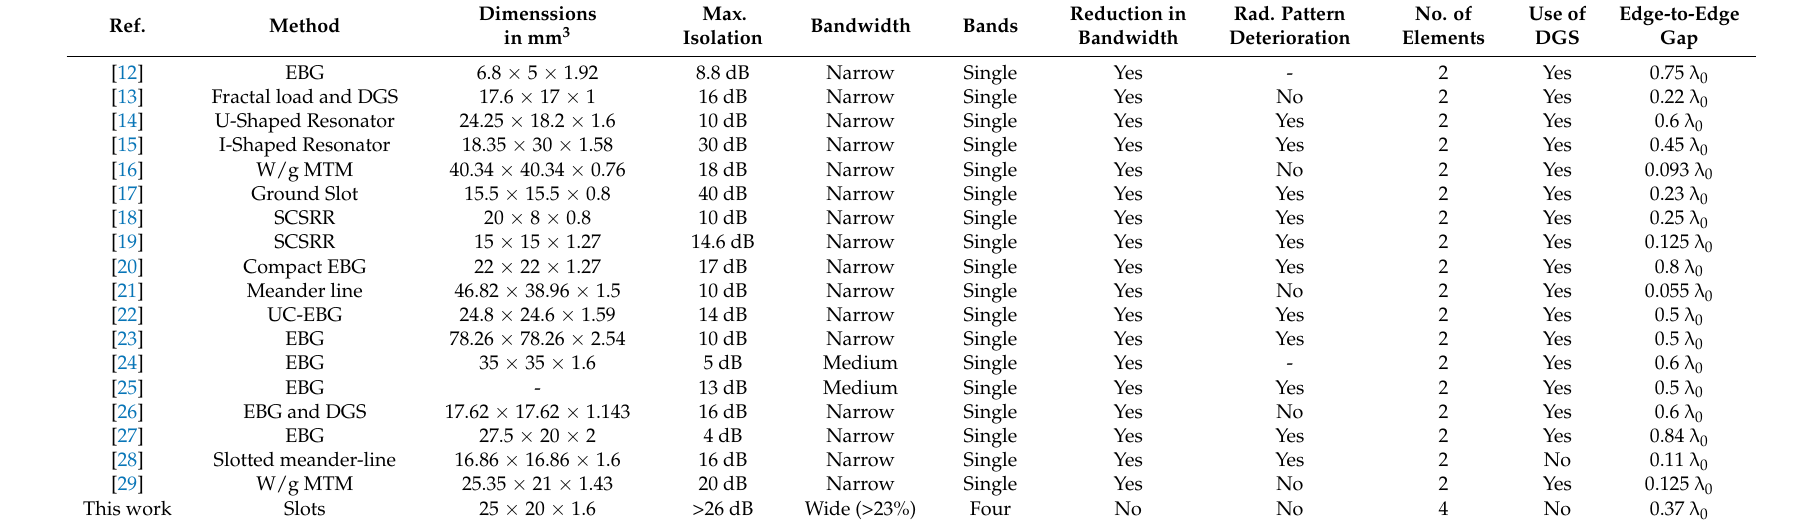
Table 5. Comparison between the proposed array with the recent